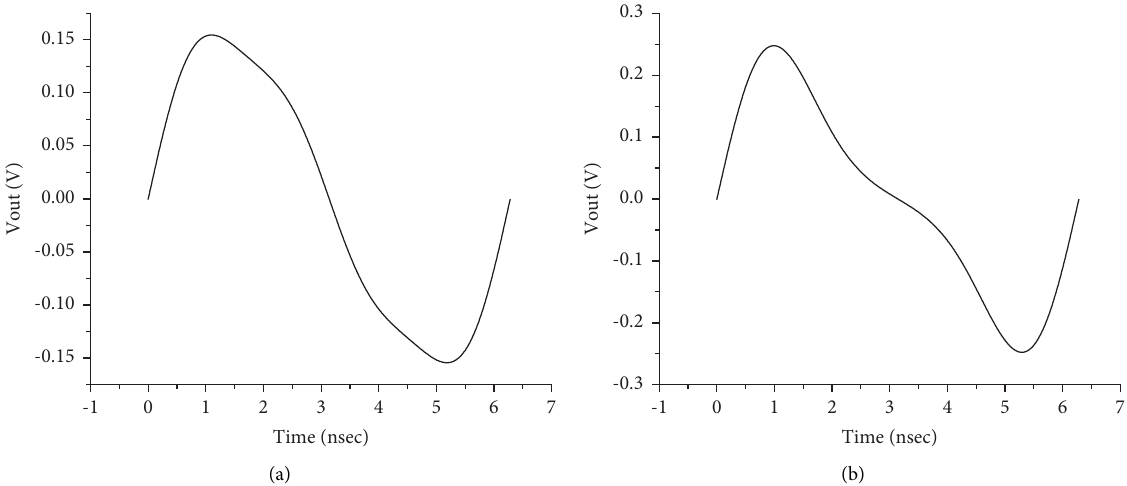
Figure 16: (a) Time domain waveform at the upper end of the SBD and (b) time domain waveform at the back end of the